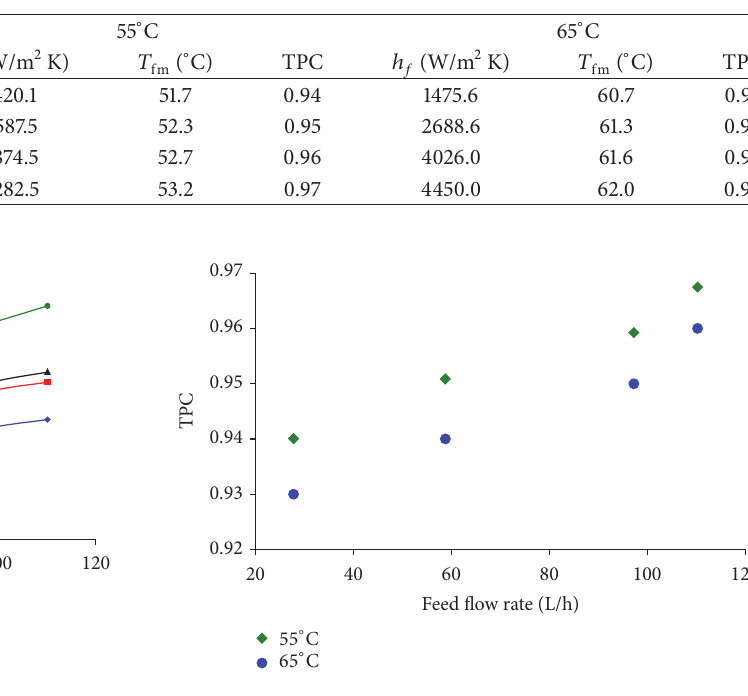
Table 4: The effect of the feed flow rate on the heat transfer coefficient, surface temperature, and temperature polarization coefficient at 55 and 65 ∘ C and a constant vacuum level of 92 kPa.